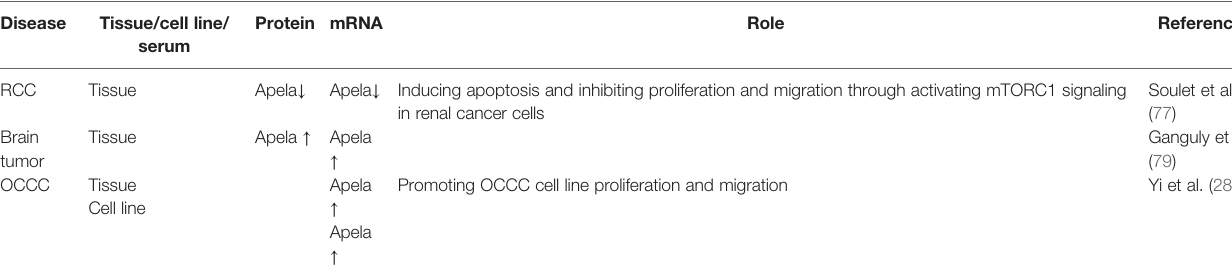
TABLE 5 | Expression and role of Apela signaling in different types of cancers.